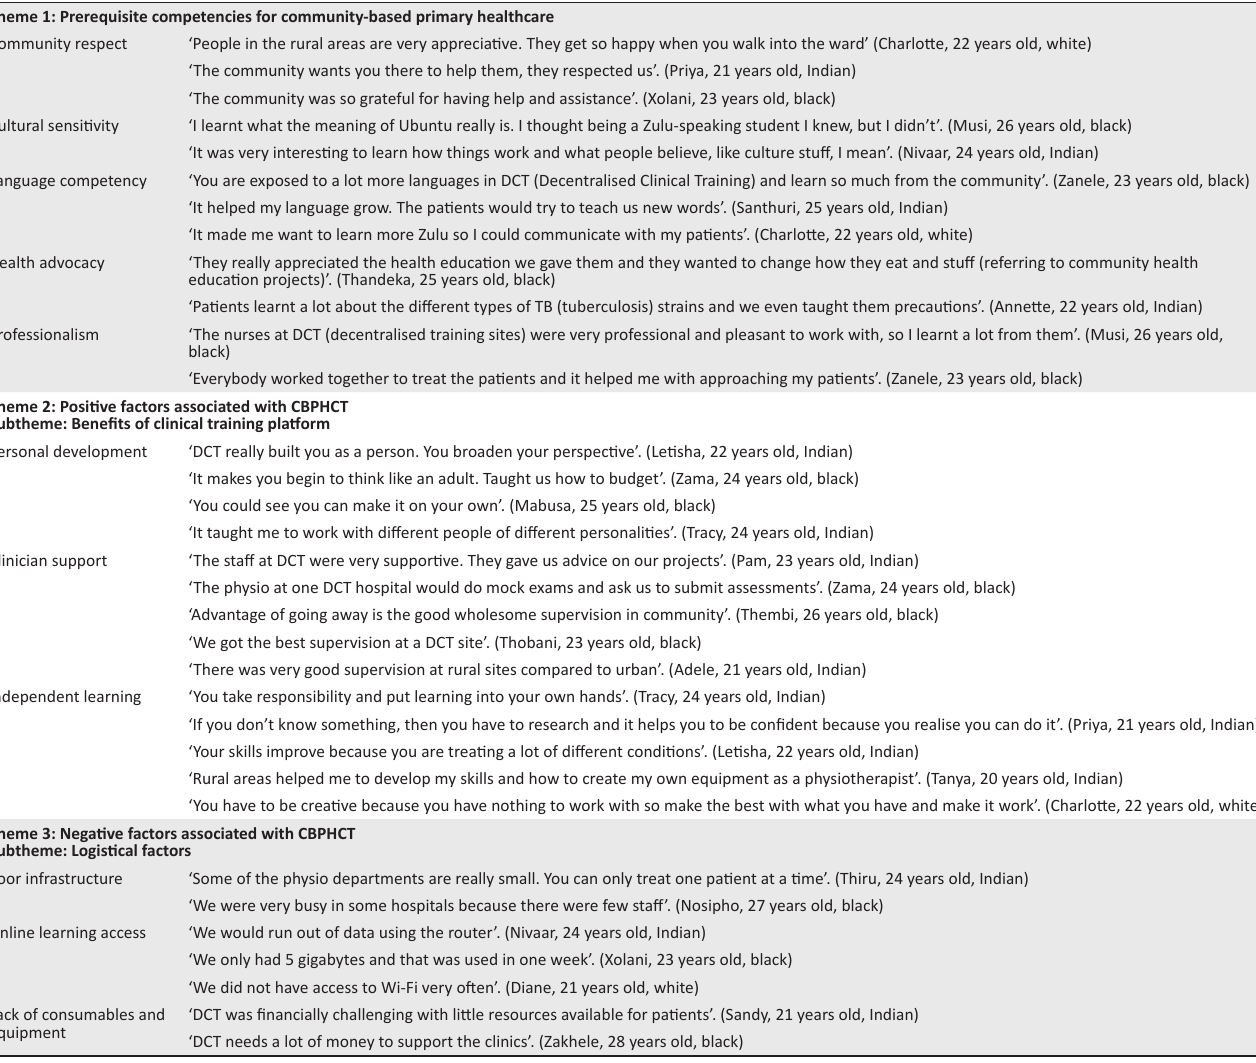
TABLE 1: Themes, subthemes, categories and illustrative